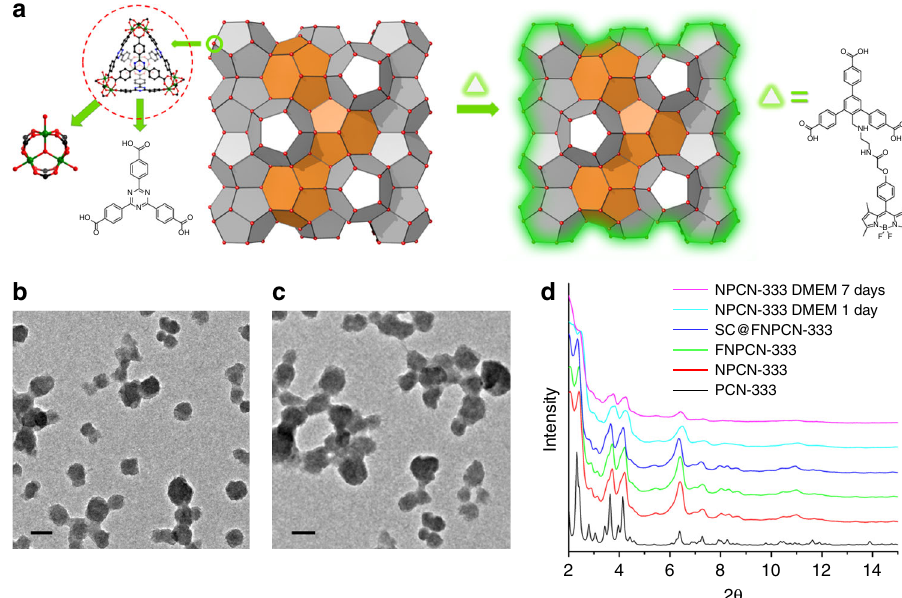
Fig. 1 Structure and characterization of PCN-333 nanoparticles. a PCN-333 is composed of trimeric clusters and TATB ligands, which self-assemble into supertetrahedra (highlighted in red dashed circle). The supertetrahedra are connected with each other in a vertex-sharing manner. A green fl uorophore is anchored on NPCN-333 via ligand metathesis. b TEM image of NPCN-333. Scale bar: 100 nm. c TEM image of FNPCN-333. Scale bar: 100 nm. d Powder X-ray diffraction patterns (2 θ from 2 to 15 degree) of microscale PCN-333 (black); NPCN-333 (red); FNPCN-333 (green); SC@FNPCN-333 (blue); NPCN-333 soaked in DMEM for 1 day (cyan); NPCN-333 soaked in DMEM for 7 days